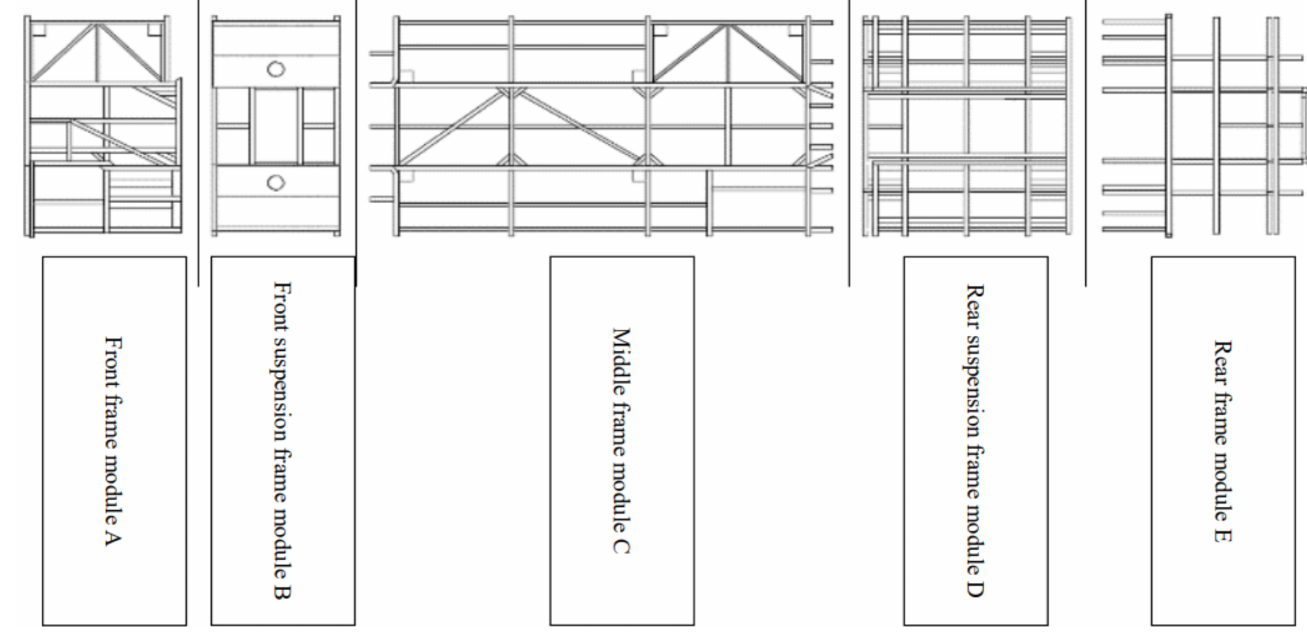
Figure 1. Bus chassis modules defined according to their functions and positions: (A) front frame module; (B) front suspension frame module; (C) middle frame module; (D) rear suspension frame module; and (*E) rear frame module. (Top view of a bus